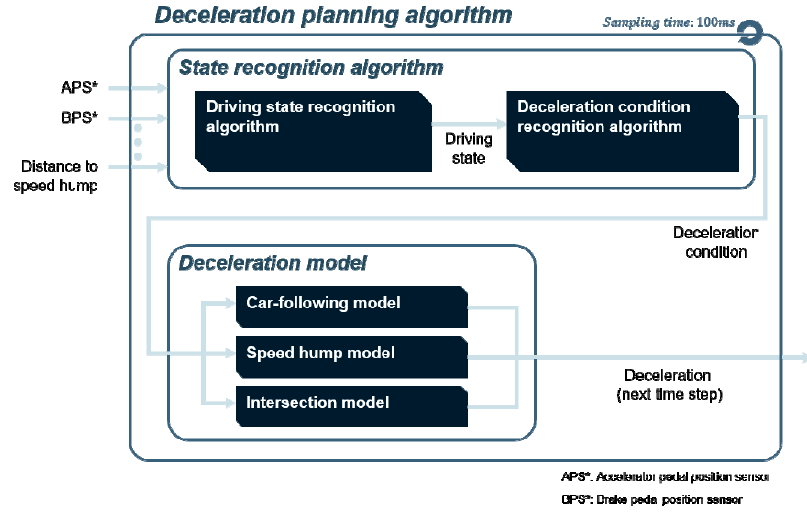
Figure 1. Overall structure of the deceleration planning algorithm.